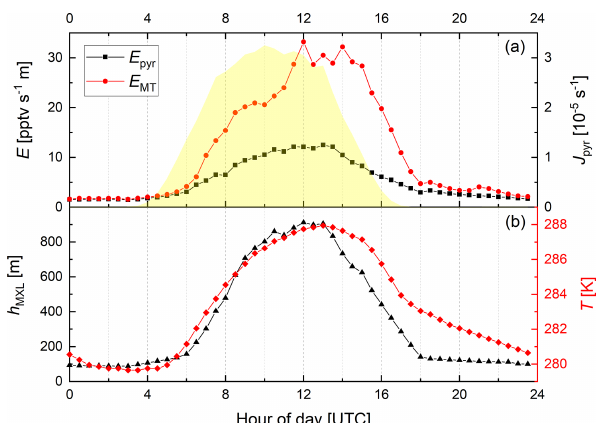
Figure 2. Diel variation of the (MXL height-corrected) emission rates of pyruvic acid ( E pyr , scenario B) and monoterpenes ( E MT ) along with J pyr (yellow shaded), T , and h MXL for the IBAIRN